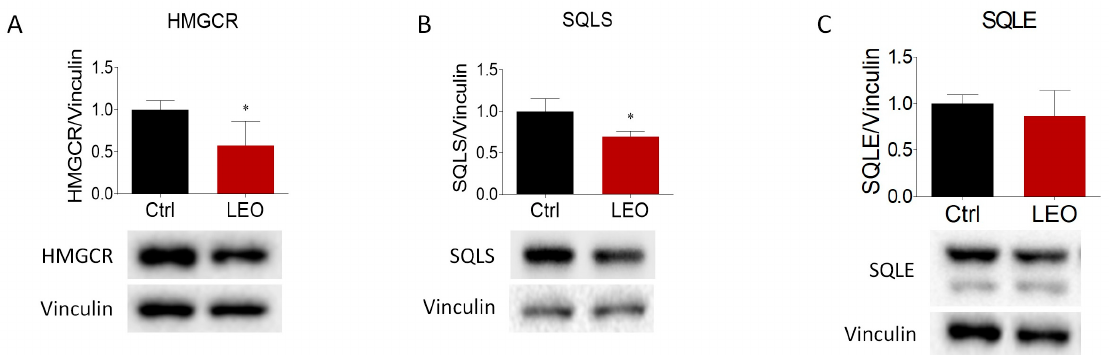
Figure 1. LEO increases the content of neutral lipids and cholesterol in HepG2 cells. ( A ) Representative images of Oil Red O staining (left panel), used to visualize intracellular neutral lipids on HepG2 cells treated with the vehicle (DMSO, Ctrl cells) or LEO (0.005%) for 24 h, and respective quantification of the mean cell intensity and the mean diameter of lipid droplets (right panel). n = 7 experimental replicates. ( B ) Representative images (left panel) and calculation of the mean integrated density (right panel) of filipin signal performed on HepG2 cells after treatments with the vehicle (Ctrl) and LEO (0.005%) for 24 h. n = 15 experimental replicates. ( C ) Quantification of intracellular cholesterol content (total cholesterol, free cholesterol, and cholesteryl esters) in vehicle- and LEO-treated HepG2 cells. n = 5 different experiments. Data represent means ± SD. Statistical analysis was assessed using the unpaired Student’s t -test. * p < 0.05; ** p < 0.01; *** p < 0.001.